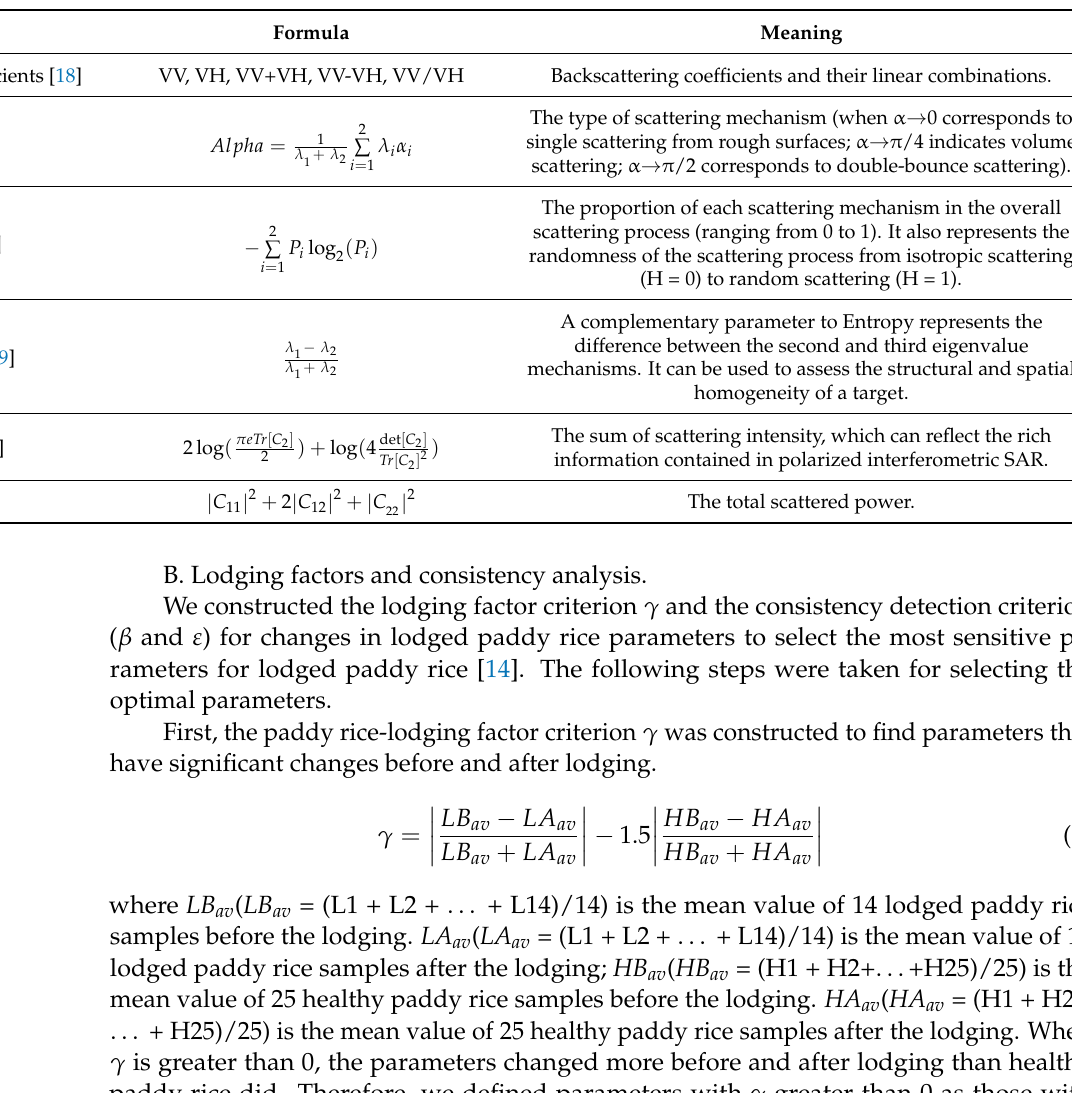
Table 3. SAR backscattering coefficients and polarimetric